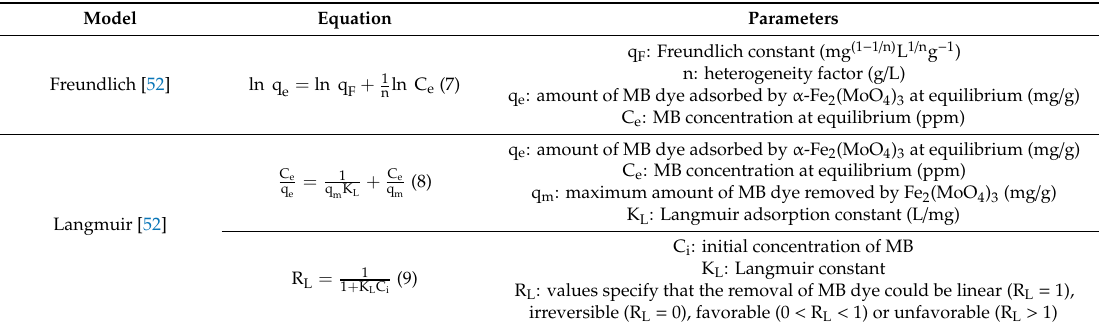
Table 4. Adsorption isotherm models for MB dye removal using Fe 2 (MoO 4 ) 3